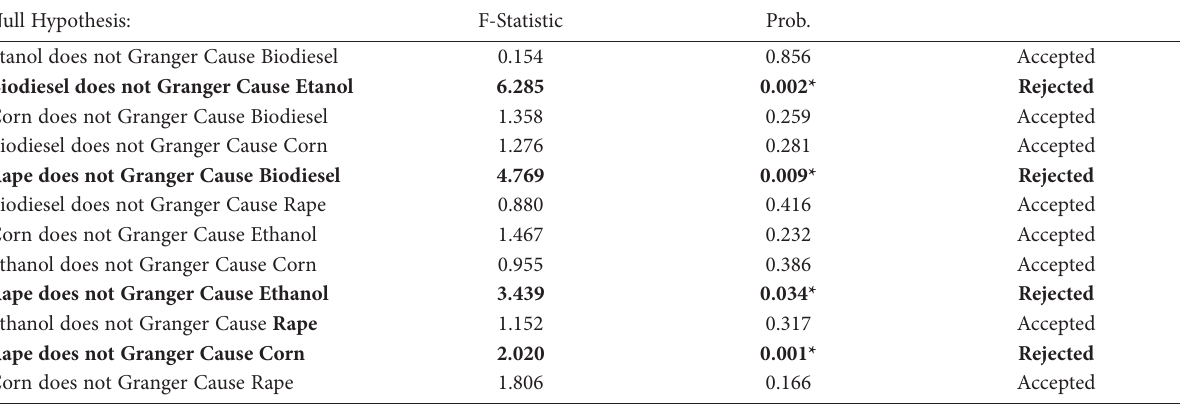
Table 4. The results of the Granger causality